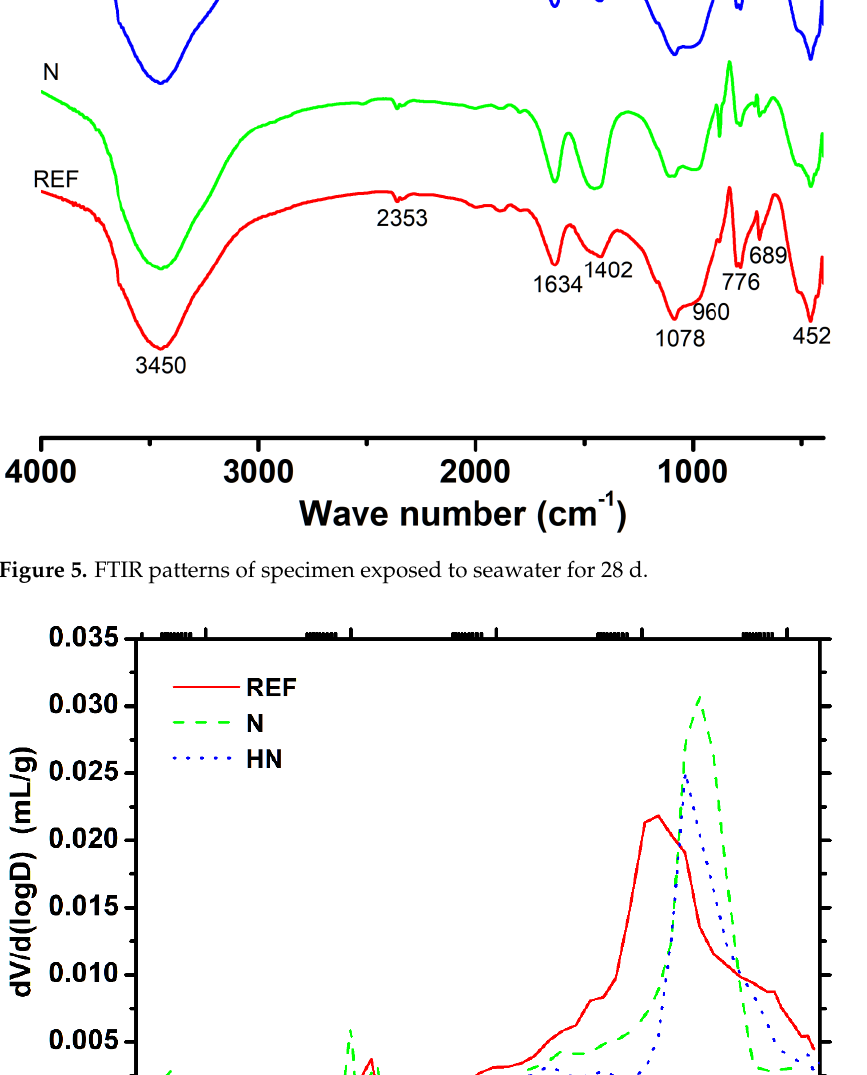
Figure 6. Differential pore volume profiles of specimens exposed to seawater for 28 d.